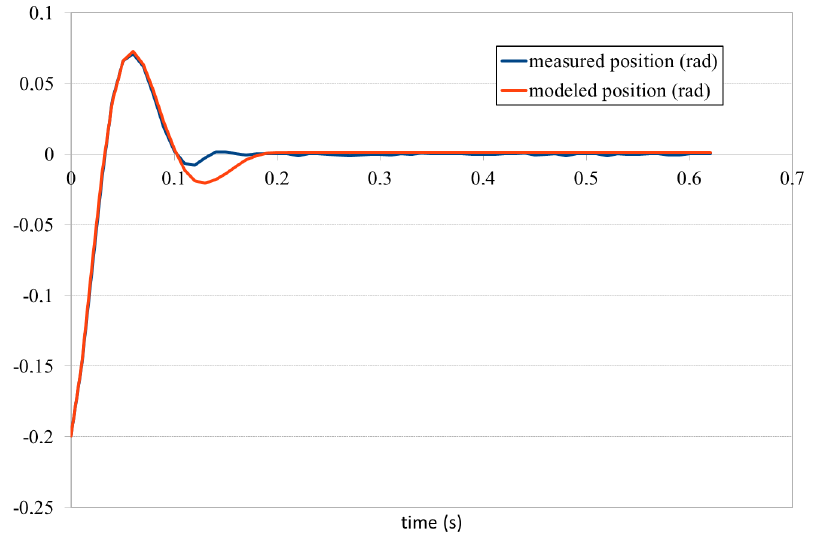
Figure 7. Angular position (rad) over time (s).